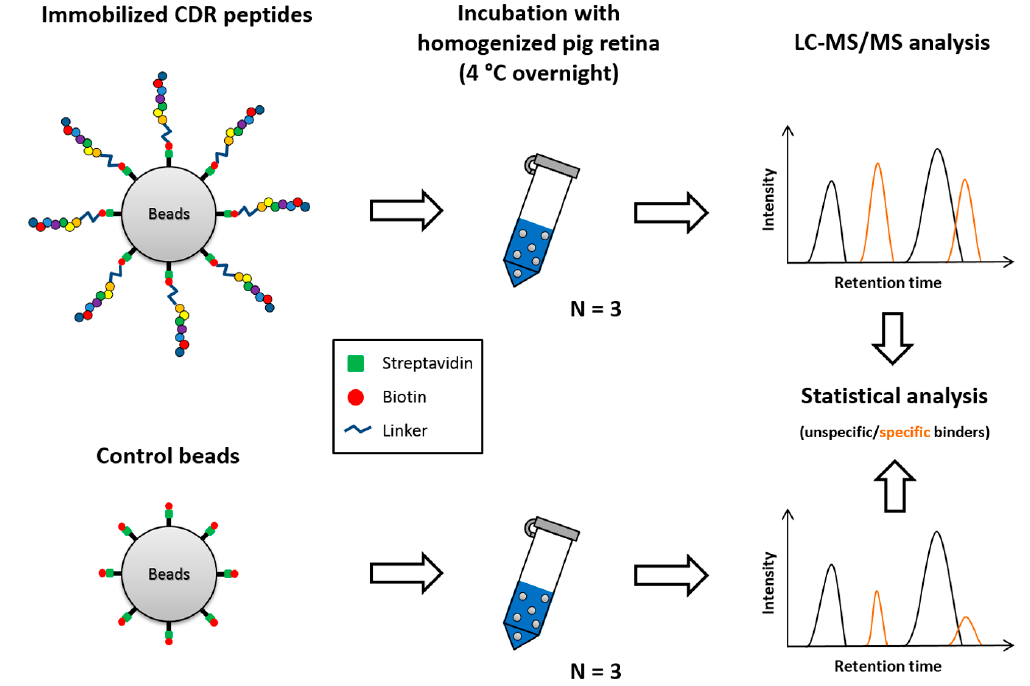
Figure 1. Schematic illustration showing affinity capture experiments of potential epitope targets by synthetic complementarity-determining regions (CDR)-derived peptides. CDR peptides were synthesized with an N-terminal [TTDS]-biotin modification by a specialist manufacturer. For epitope identification the modified synthetic peptides (80 µg) were attached to commercially available streptavidin beads and incubated with 5 mg homogenized pig retina. To distinguish non-specific from specific protein binders a biotin-labeled control group was included in the analysis. After incubation, all bead fractions were extensively washed and the remaining attached proteins were eluted by pH shift. Eluate fractions were subjected to further in-solution trypsin digestion and analyzed by LC-MS/MS. Statistical analysis revealed high-affinity epitope targets (interaction partners) of the synthetic CDR peptides.